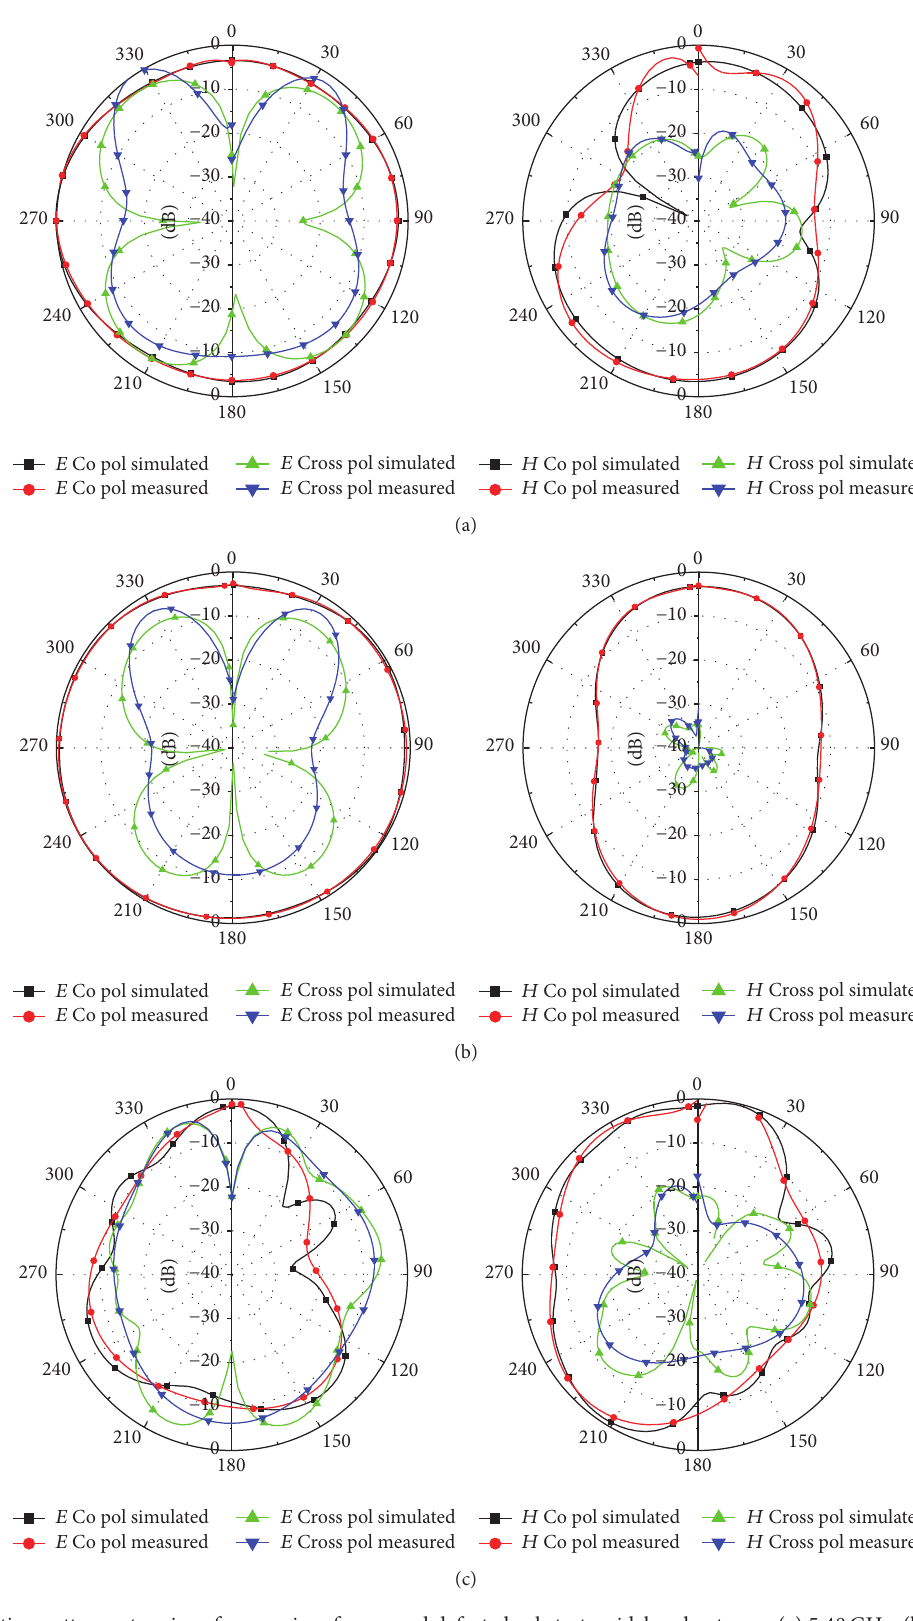
Figure 14: Radiation patterns at various frequencies of proposed defected substrate wideband antenna: (a) 5.48 GHz, (b) 8.03 GHz, and (c)